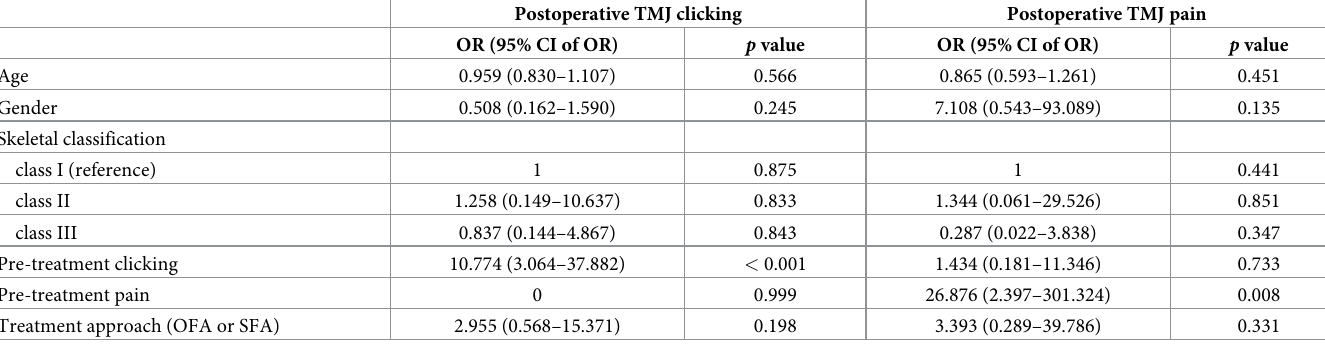
Table 7. Results of the logistic regression analysis to determine significant variables affecting postoperative TMJ clicking and pain.